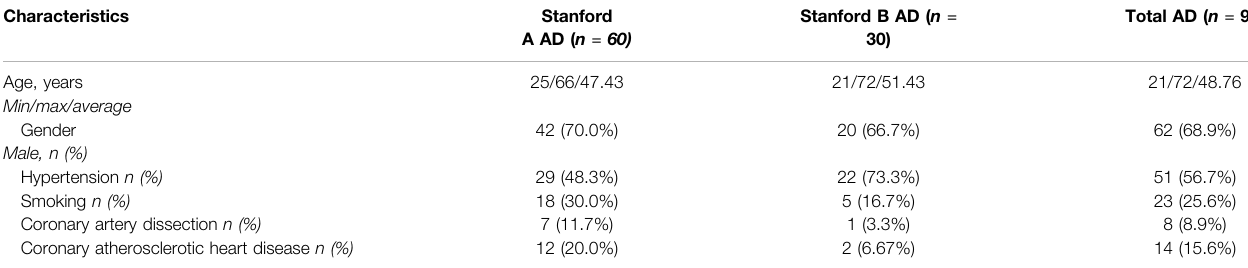
TABLE 1 | The demographic and clinical features of study